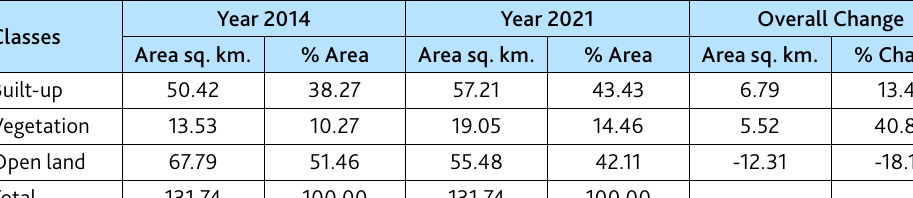
Table 8. Change detection Statistics for Rajkot data set